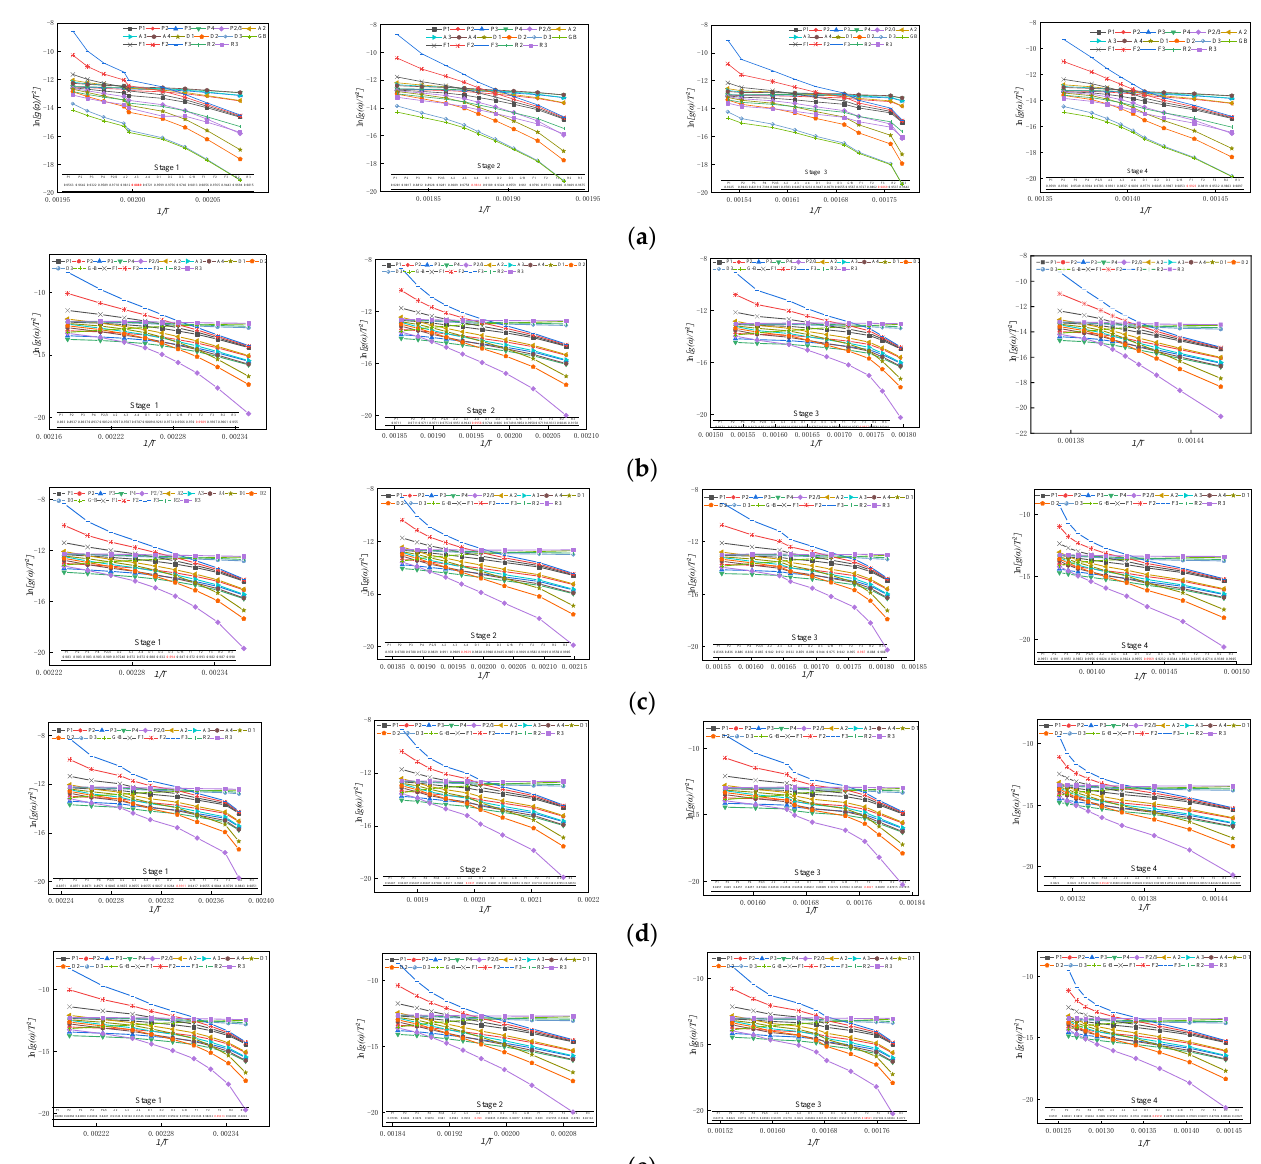
Figure 14. Fitting curve of the most likely reaction mechanism model of Samples P1 – P5 formula obtained via the Coats – Redfern method. ( a ) Fitting curve of P1′s reaction mechanism model. ( b ) Fitting curve of P2′s reaction mechanism model. ( c ) Fitting curve of P3′s reaction mechanism model. ( d ) Fitting curve of P4′s reaction mech anism model. ( e ) Fitting curve of P5′s reaction mechanism model.